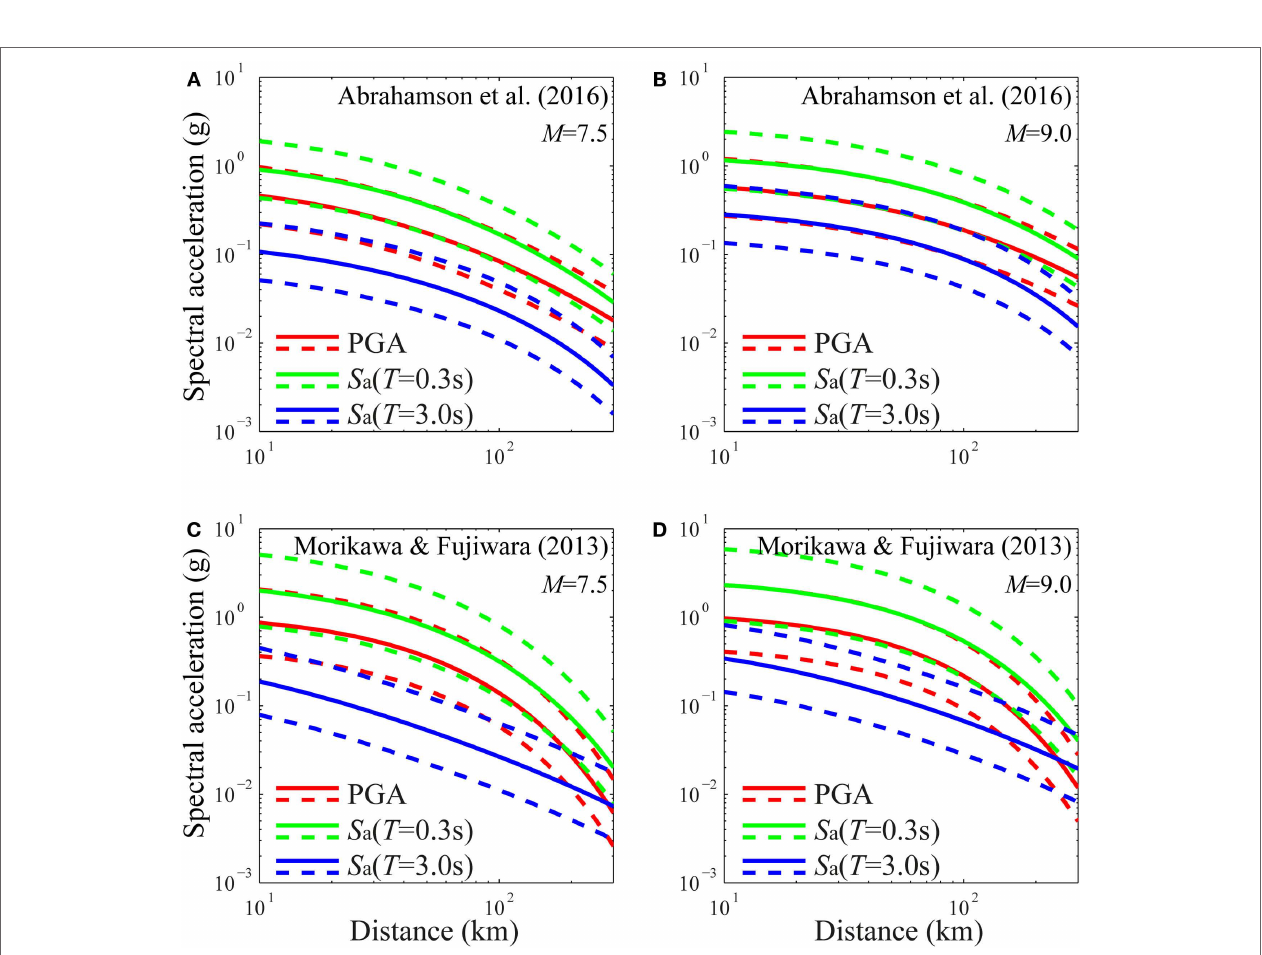
FIGURE 5 | Comparison of GMPEs . (A) Abrahamson et al. GMPE for M = 7.5 and V S30 = 300m/s. (B) Abrahamson et al. GMPE for M = 9.0 and V S30 = 300m/s. (C) Morikawa–Fujiwara GMPE for M = 7.5 and V S30 = 300m/s. (D) Morikawa–Fujiwara GMPE for M = 9.0 and V S30 = 300m/s.